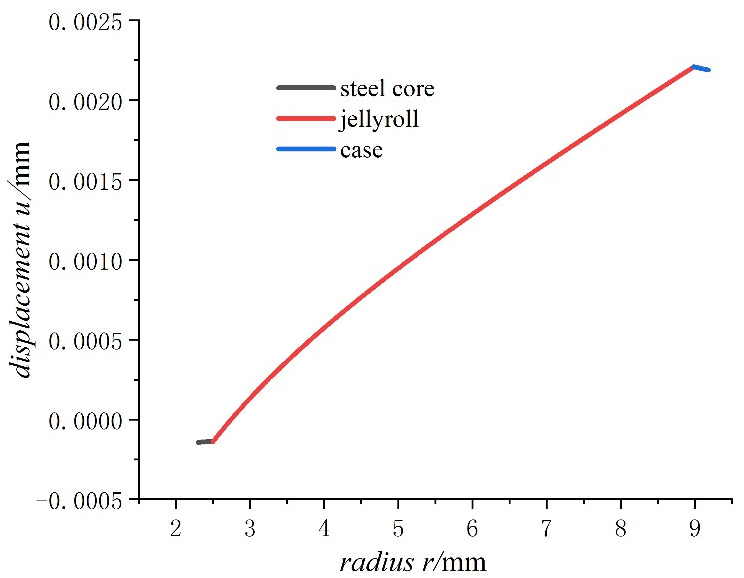
Figure 4. Displacements of 18650 battery on a fully charged state.